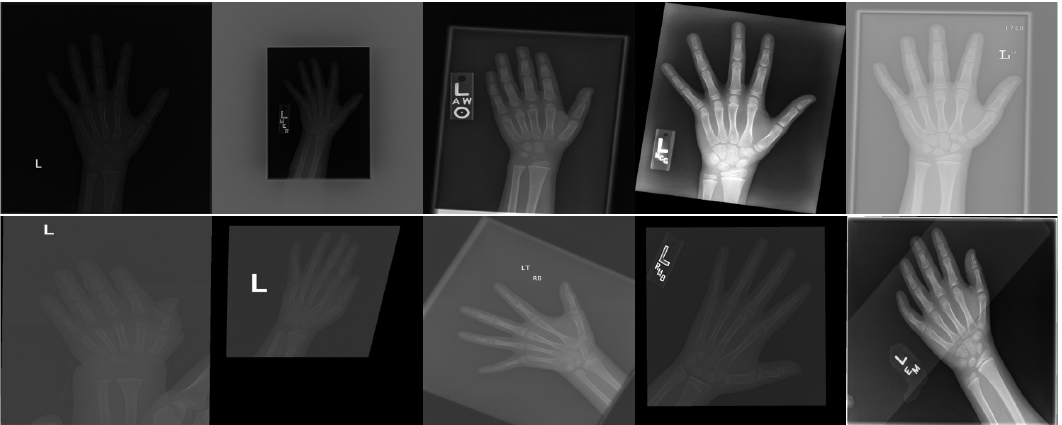
Figure 2. The first-row images depict some hand X-ray images taken with various contrast values. The second-row images depict some hand X-ray images taken from various tilting pose